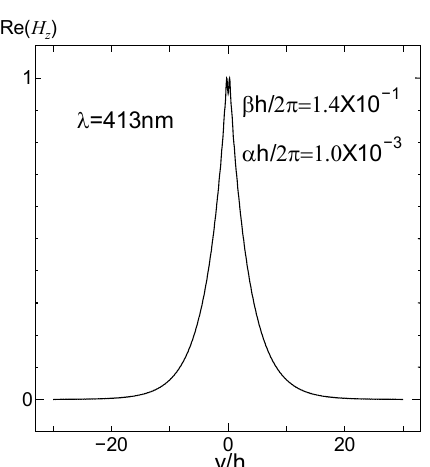
Figure 6. Distribution of the Hz field as a function of the y coordinate representing the wavelength of 413 nm.